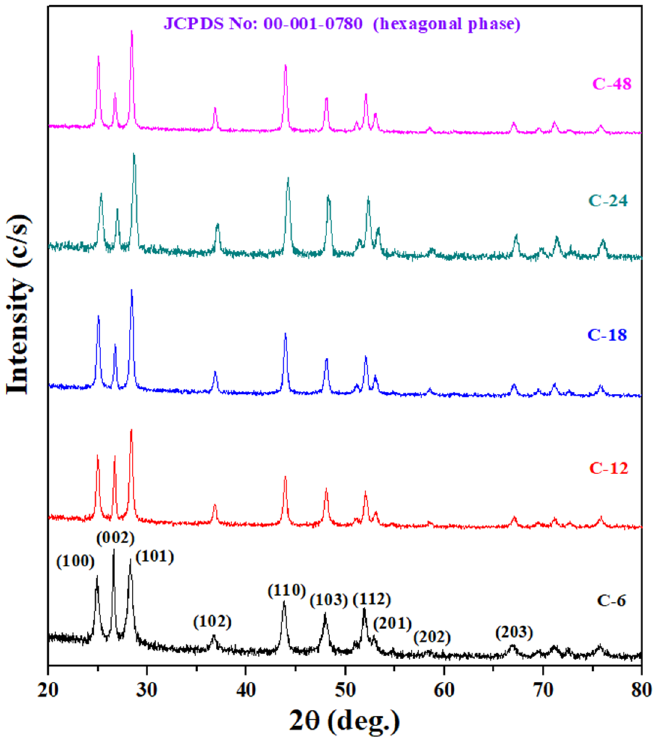
Figure 3. Powder XRD patterns of CdS nanorods obtained at different reaction times.